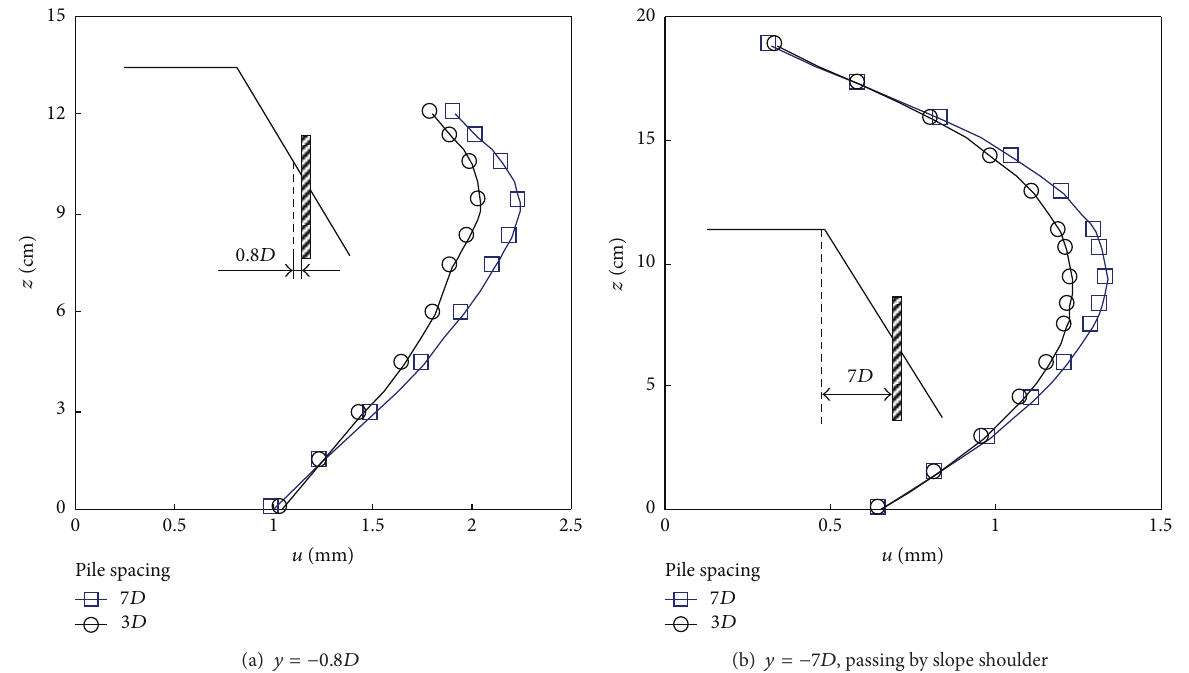
Figure 16: Influence of pile spacing by numerical analysis. D : pile diameter; u : horizontal